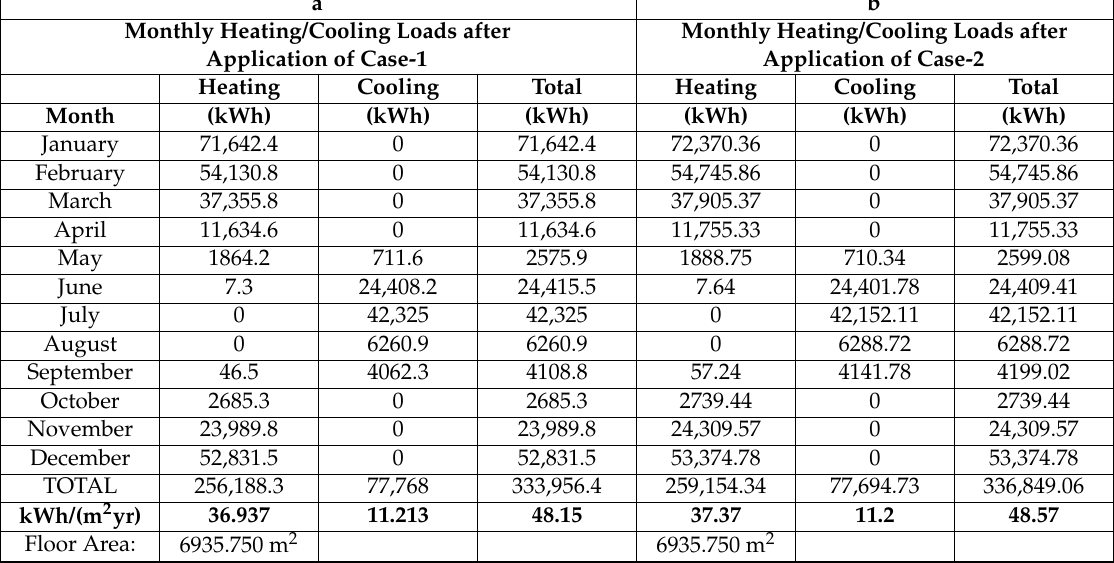
Table 7. (a) Total energy demand of a building after application of case-1. (b) Total energy demand of a building after application of